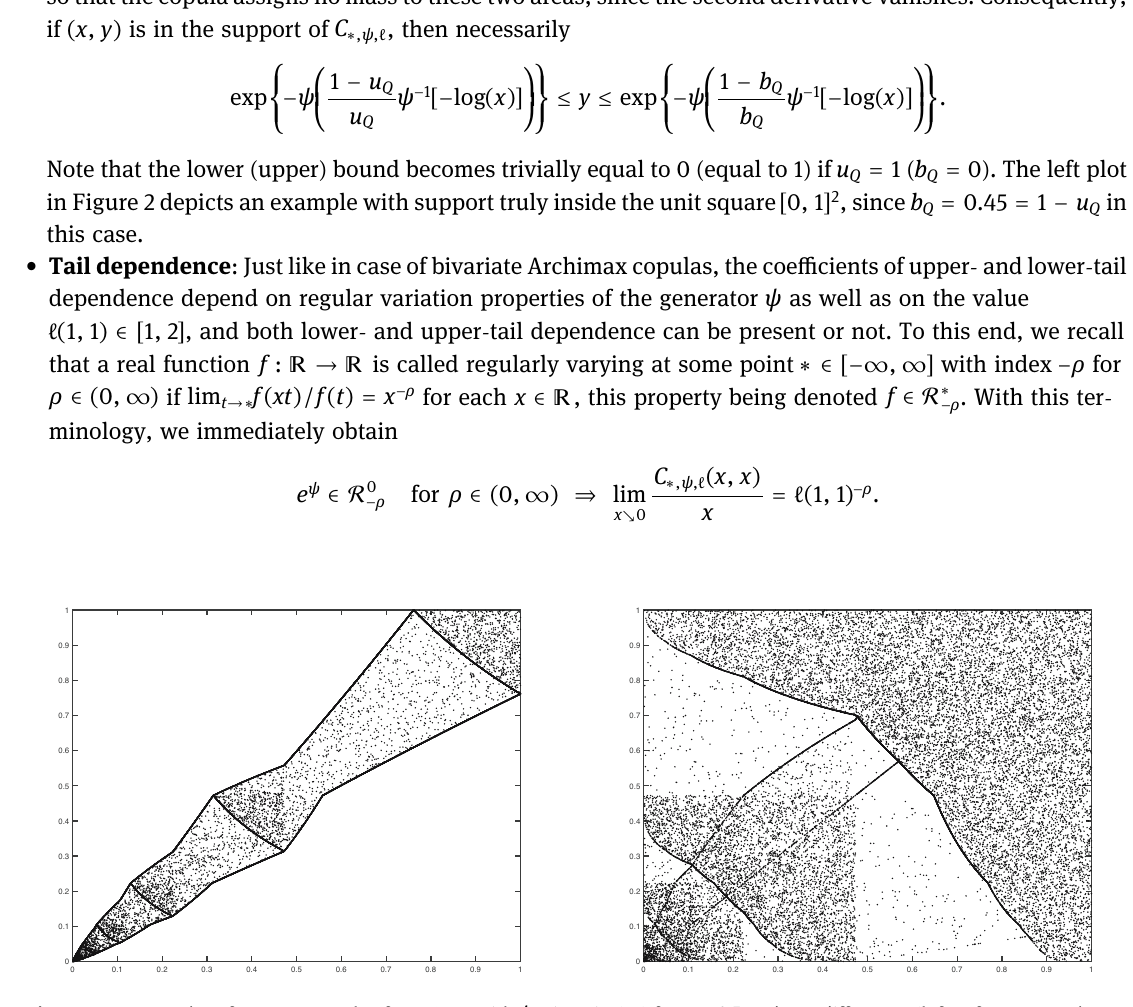
given in ( 13 ) for = a 1.5 and two di ff erent ℓ ( left: ℓ from Example 4.4 Figure 2: Scatter plot of 25,000 samples from ∗ ℓ C ψ , , with ψ a with = q 0.45 , right: ℓ piece - wise constant corresponding to some ( asymmetric ) Q with six atoms and ( ) ( ) = = > Q Q 0 , 1 0 (cid:2) (cid:2)